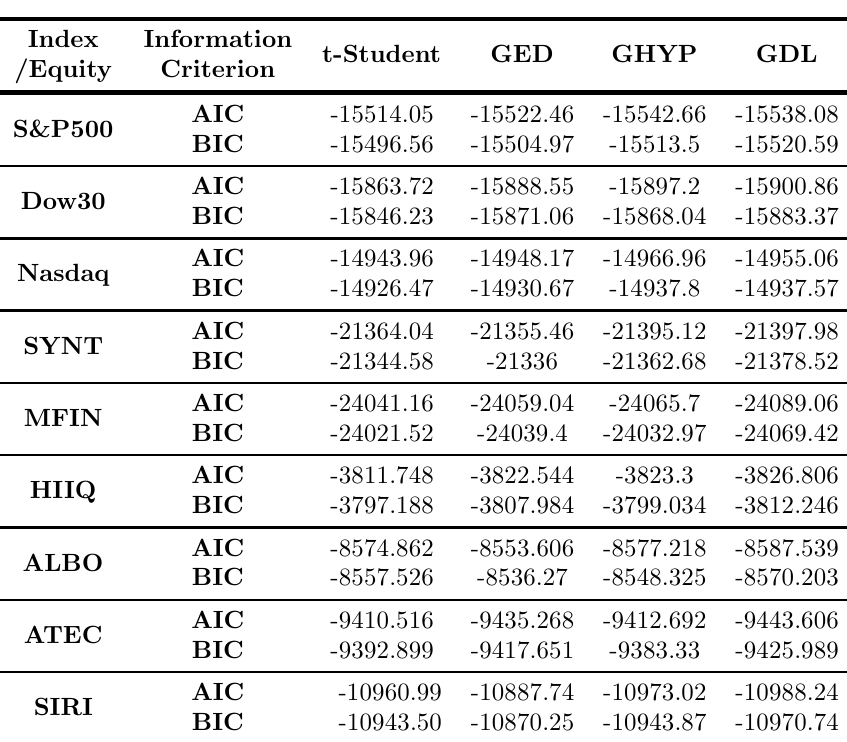
Comparisons between the fitted